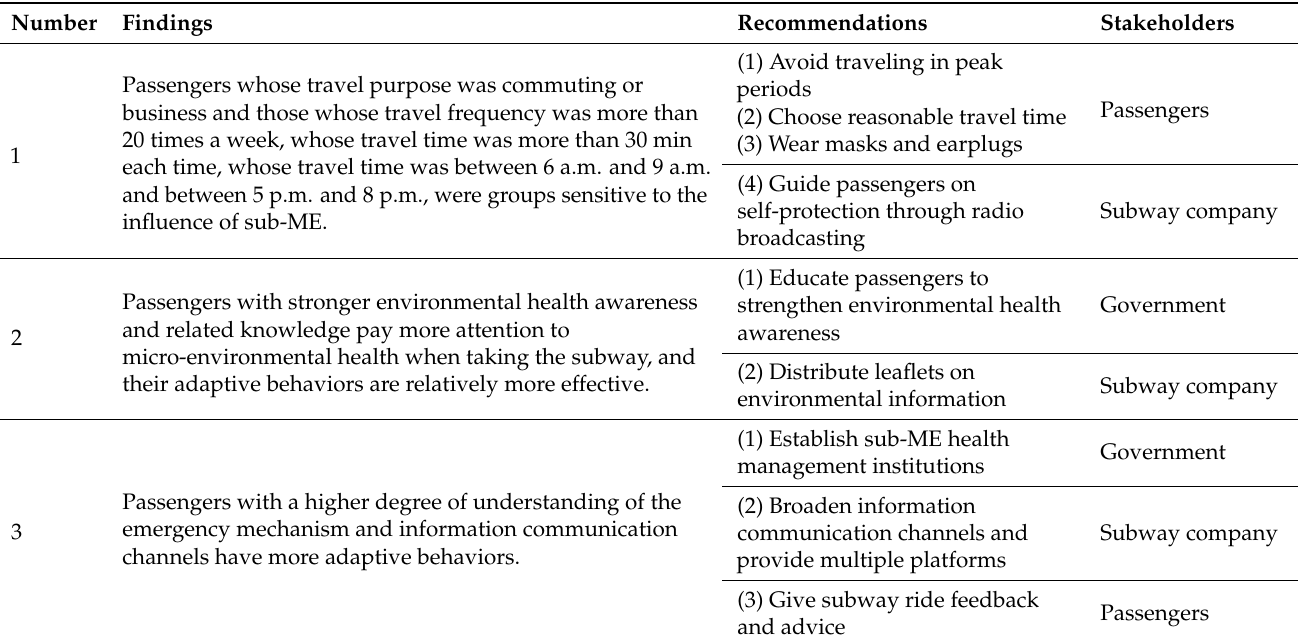
Table 7. Recommendations for